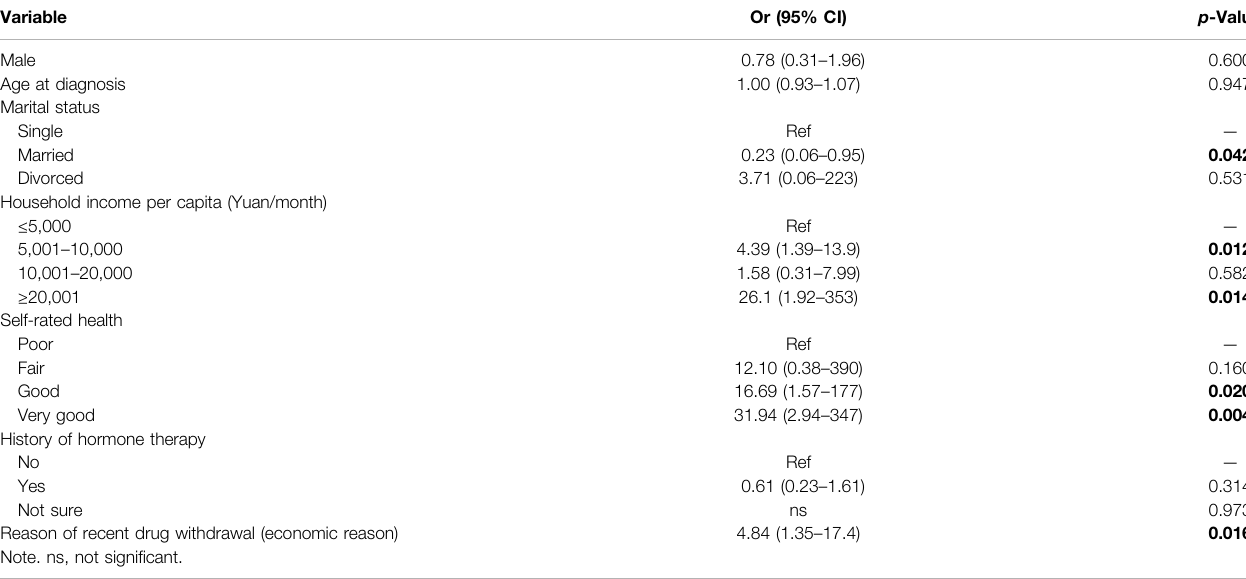
TABLE 9 | Multivariate logistic regression analysis of predictive factors for preference toward impact of UST administration on everyday life.